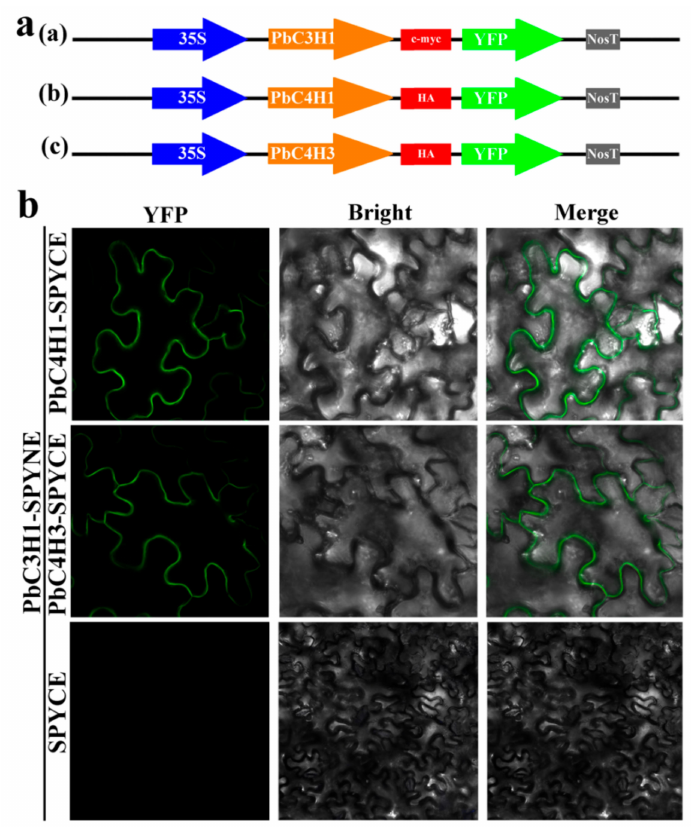
Figure13. In vivoBiFCanalysisofinteractionbetween PbC3H and PbC4H co-expressedin N.benthamiana leaf cells. The coding regions of PbC3H and PbC4H were fused to the N-terminal and C-terminal halves of YFP, respectively. ( a ): Schematic representation of the 35S: PbC3H1-YFP, 35S: PbC4H1-YFP, and 35S: